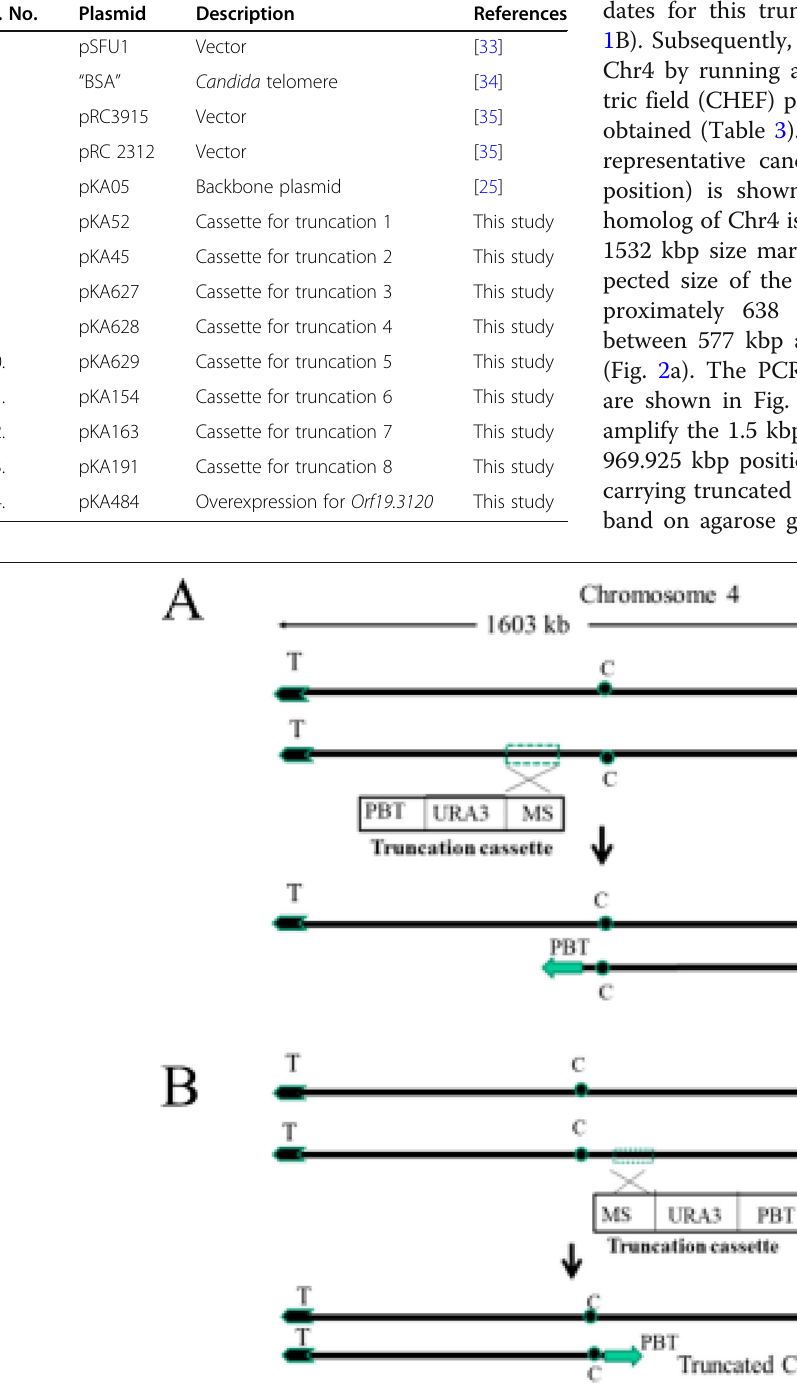
Fig. 1 Schematic diagram of chromosomal truncation. A Truncation on the left side of the centromere of chromosome 4. Two thick lines represent two homologs of Chr4 containing a centromere (C) in the middle and two telomeres at the ends (T). Truncation cassette has three essential components: PBT, plasmid-borne telomere sequence cloned in the same orientation as it is present in the cellular chromosome; MS, mapping sequence retrieved from the chromosomal sequence at which truncation is intended; and URA3 , selection marker. B Truncation of Chr4 on the right-hand side of centromere. Truncation cassettes are made similarly to left portion truncation. However, the telomere sequence will face towards the right and will replace the cellular right portion telomere. Truncation on either side of the centromere generates a truncated homolog of Chr4 wherein the second homolog remains